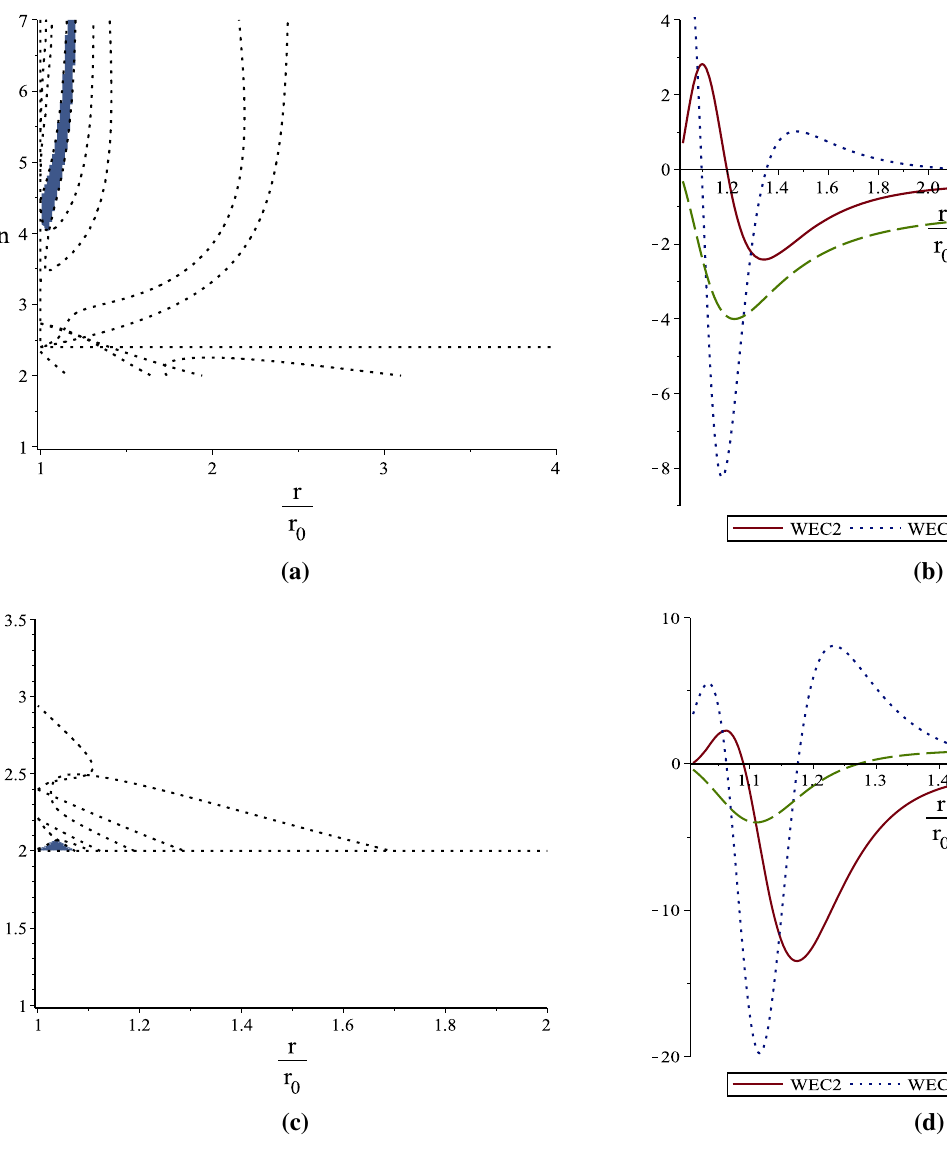
in this model respect NEC around the throat. d Demonstrates that for an asymptotically open wormhole with n = 2 . 02 , r 0 = 0 . 5, NEC is respected around the throat. In these figures we set μ = 5 , R ∗ =